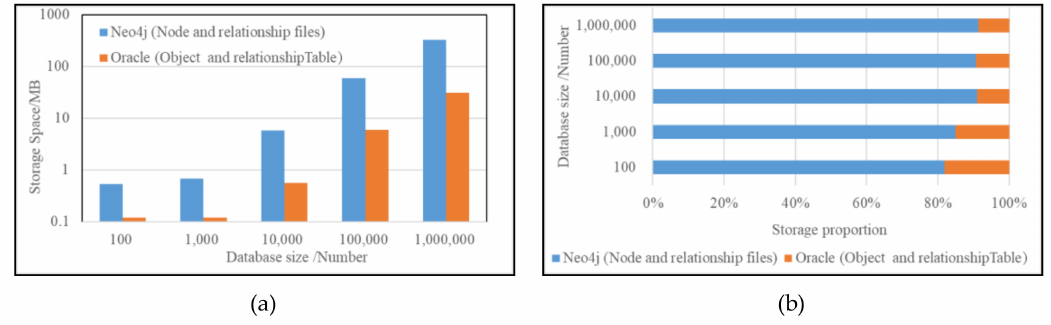
Figure 11. Comparisons of the database storage capacities.